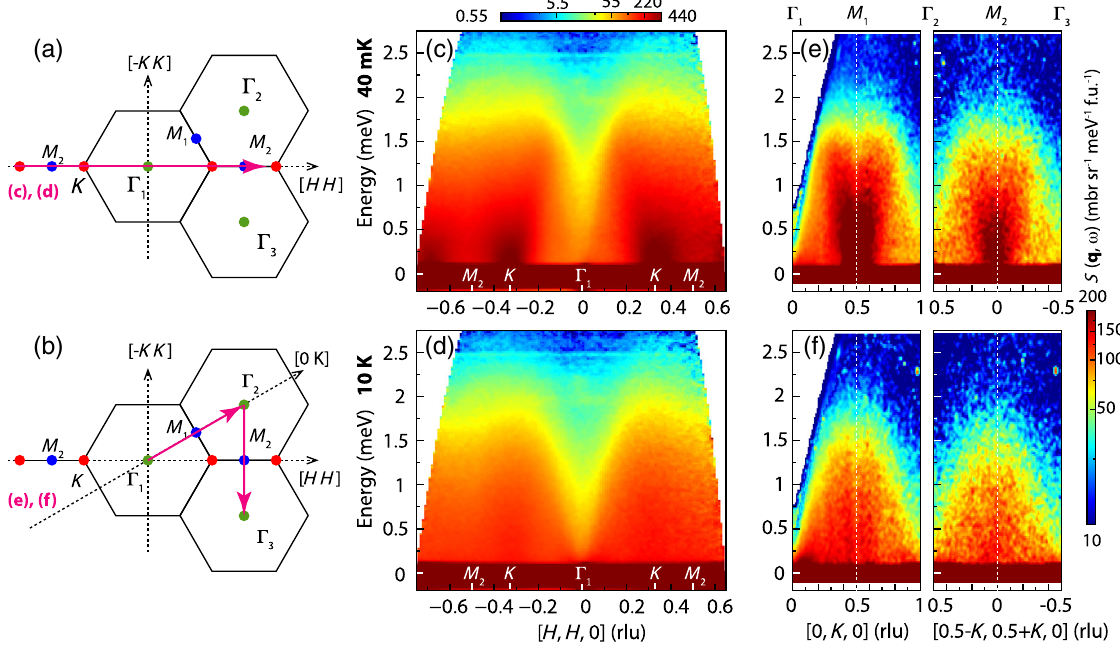
FIG. 4. Spin-excitation spectra along high symmetry momentum directions. (a),(b) Schematics of the Brillouin zones with high symmetry points Γ , K , and M denoted by green, red, and blue dots, respectively, and the high symmetry directions for the images in (c) – (f) marked by pink lines with arrow heads. Spin-excitation spectra collected at (c) T ¼ 40 mK and (d) 10 K along the M 2 - K - Γ - K - M 2 with E i ¼ 3 . 32 meV. (e),(f) Intensity color maps along the Γ 1 - M 1 - Γ 2 and Γ 2 - M 2 - Γ 3 directions measured with E i ¼ 3 . 7